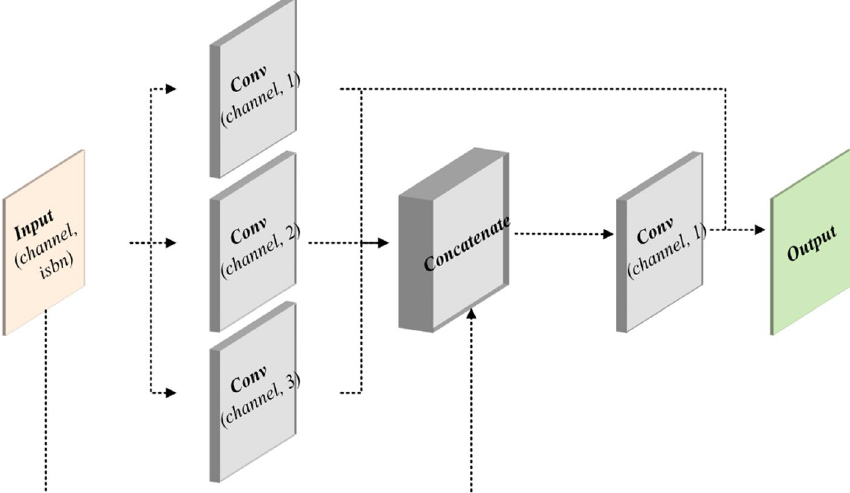
Fig. 3 CCB. Channel represents the number of channels of input feature vector. Isbn represents whether to add batch normalization to each convolution